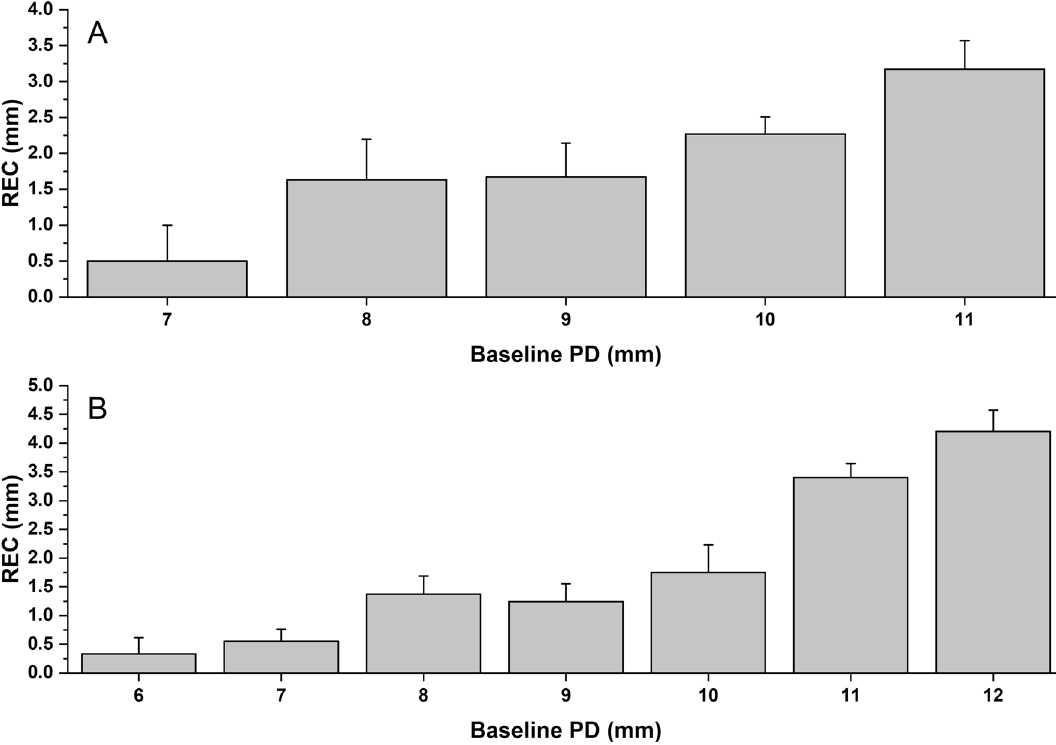
Figure 3. Relationship between the baseline PD and the amount of REC observed at the 3–6 months re-evaluation appointment in the OFD ( A ) and SRP ( B )